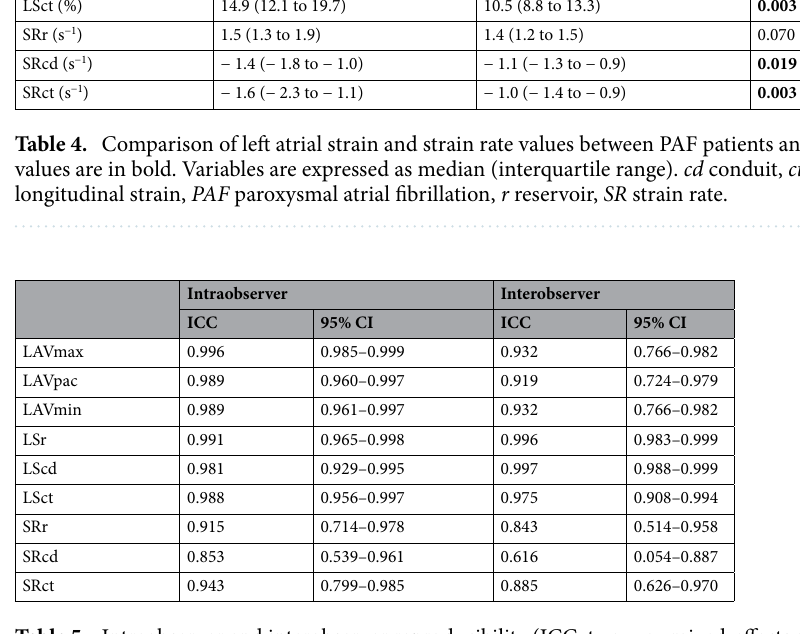
Table 5. Intraobserver and interobserver reproducibility (ICC, two-way mixed-effects model) of LA volumes, strain and strain rate determined from two measurements of ten random subjects. cd conduit, ct contractile, CI confidence interval, ICC intraclass correlation coefficient, LS longitudinal strain, SR strain rate, r